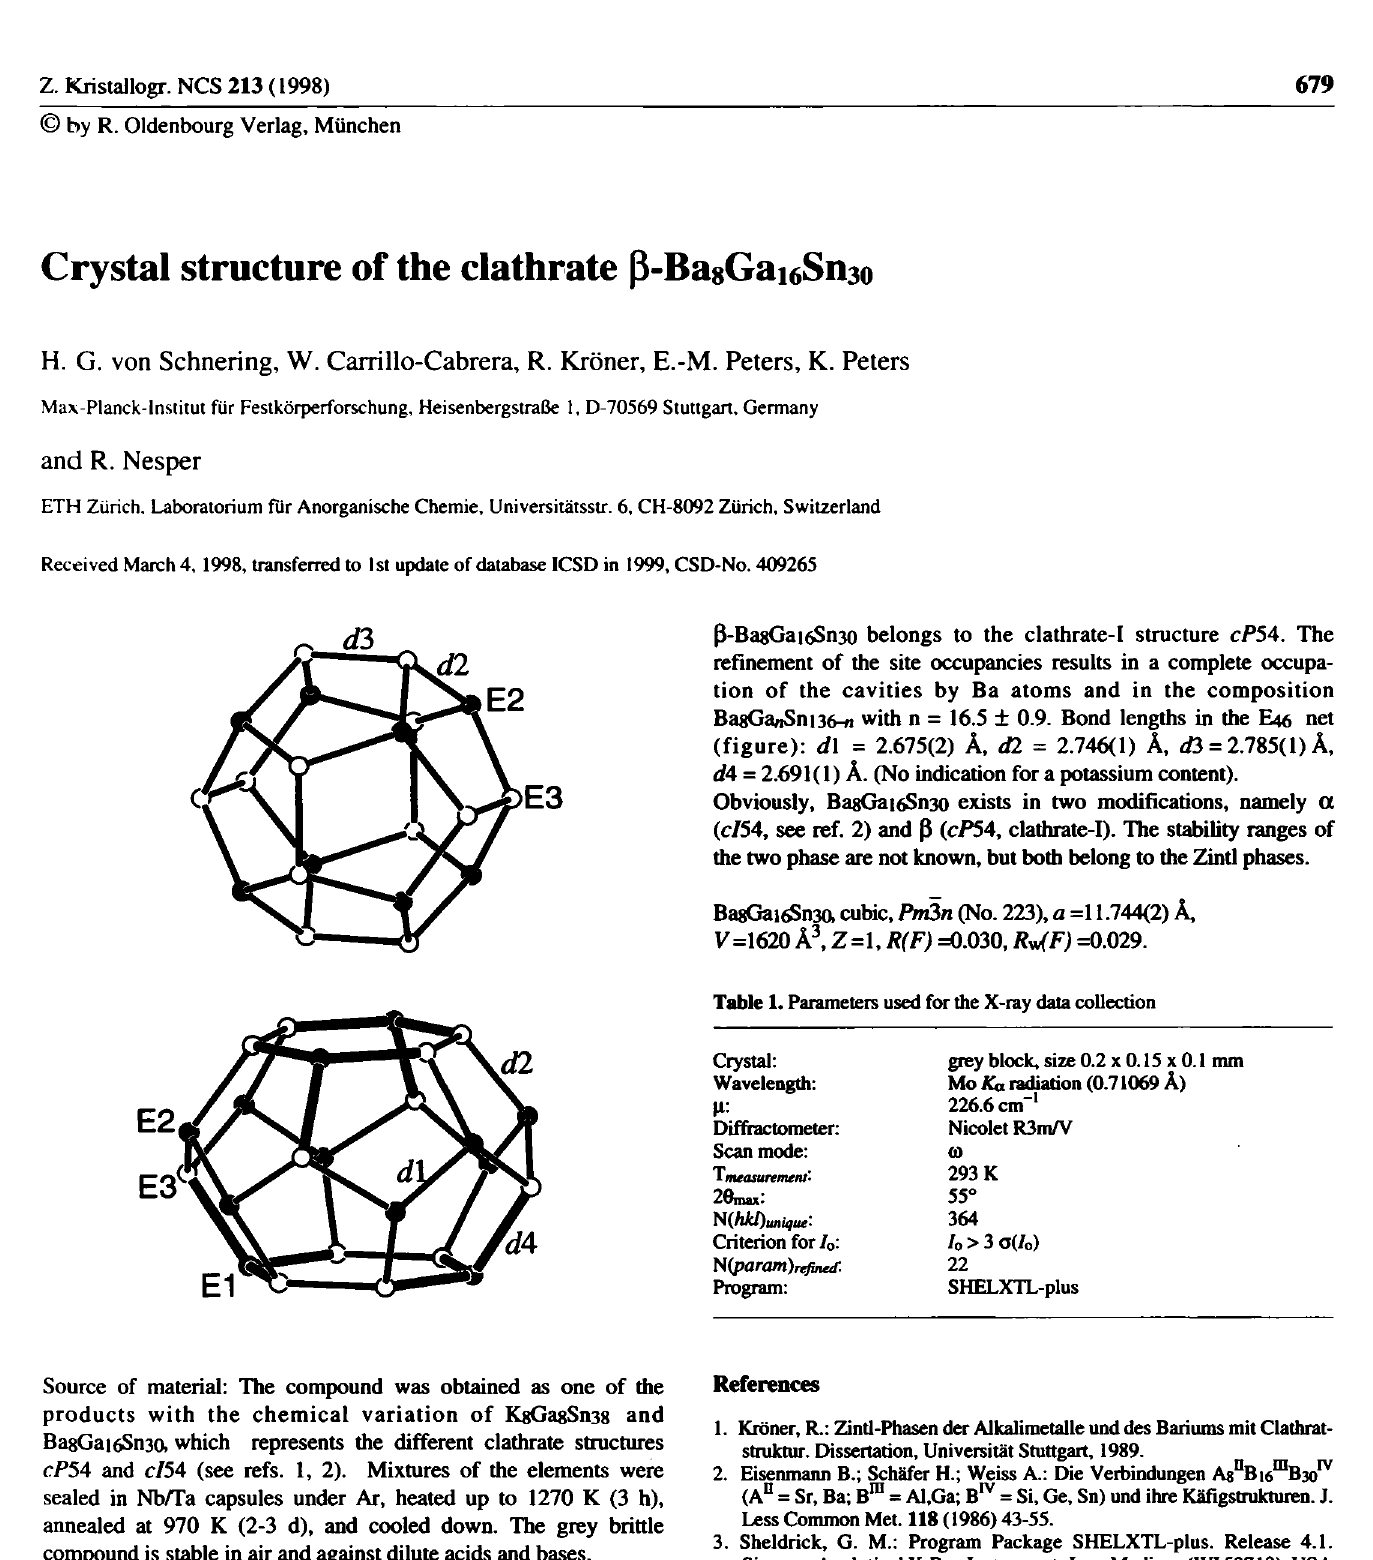
Table 2. Final atomic coordinates and displacement parameters (in